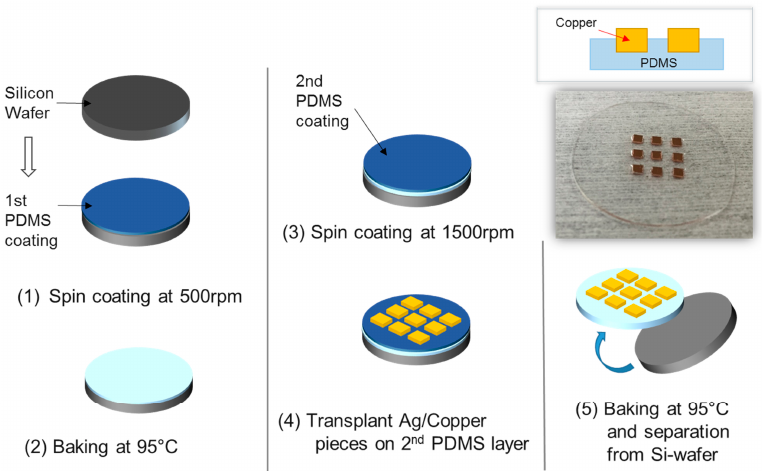
Figure 3. Fabrication process of the PDMS boat.